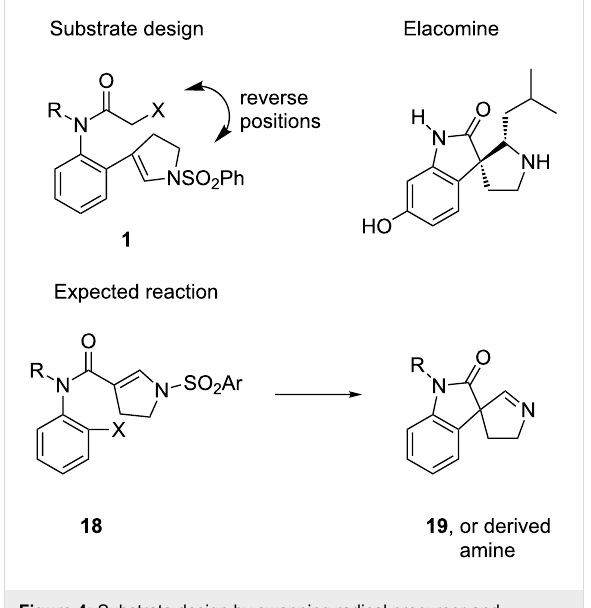
Figure 4: Substrate design by swapping radical precursor and